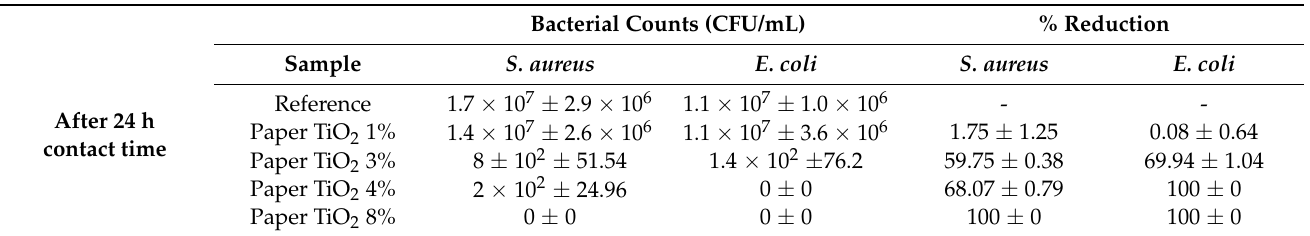
Table 2. Viable bacterial counts (colony-forming unit (CFU)/mL) after 24 h contact time showing log reduction in treated sample compared to untreated sample.